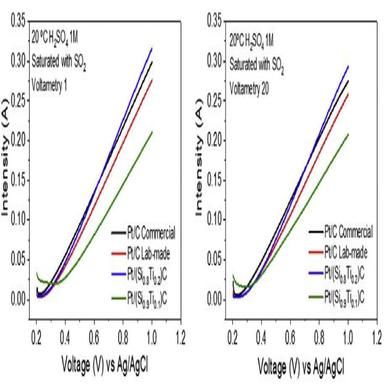
Lineal Voltammetries for the different catalysts. Conditions: 20 C, 1 M H2SO4 (saturated with N2). a) 1st lineal Voltammetry, b) 20th Lineal Voltammetry.